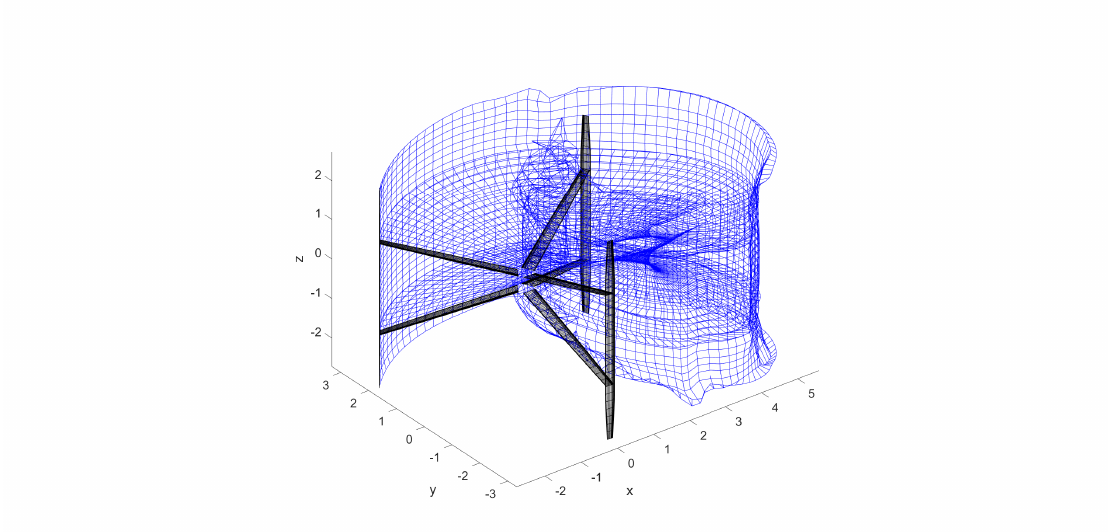
Figure 2. Illustration of filaments from one blade after the first revolution. Each blue line represent one vortex filament in the wake and the black lines represent the filaments used to solve the potential flow for the angle of attack calculation. Each blade will have one of these filament lattices behind them (although only one of them is shown